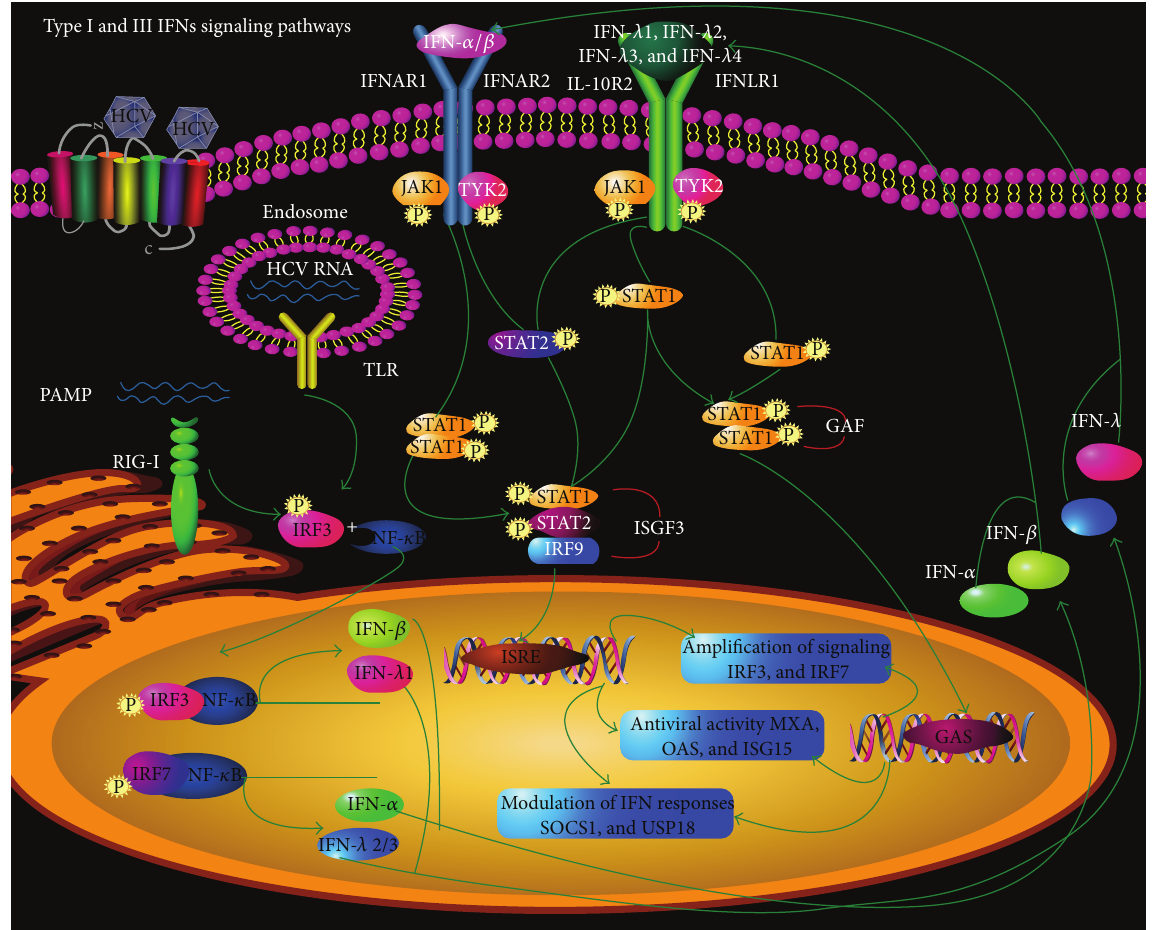
Figure 2: Types I and III IFNs canonical signaling pathways. Viruses, including HCV, are recognized by pattern recognition receptor (PRR), TLR3, and/or RIG-I-like receptor, leading to the activation of kinases. This in turn results in phosphorylation of IRF3 and IRF7 and activation of NF- 𝜅 B. They translocate to nucleus to form heterodimers, respectively, which can catalyze transcription of IFN- 𝛼 , IFN- 𝛽 , and IFN- 𝜆 genes by binding to specific DNA sequences. Then, Types I and III IFNs move out of nucleus to bind to their specific receptors on the cell membrane and trigger an overlap pathway, Jak/STAT signaling pathway. Upon binding to their cognate receptors, Type I can phosphorylate both STAT1 and STAT2 to form ISGF3 that binds to ISRE in the promoter region of ISGs to upregulate their transcription and Type III IFN also can phosphorylate STAT1 to form a homodimer GAF and induce ISGs expression with GAS in the promoter region. A myriad of ISG products is not only antiviral factors but also participation in the signaling pathway in virtue of positive/negative